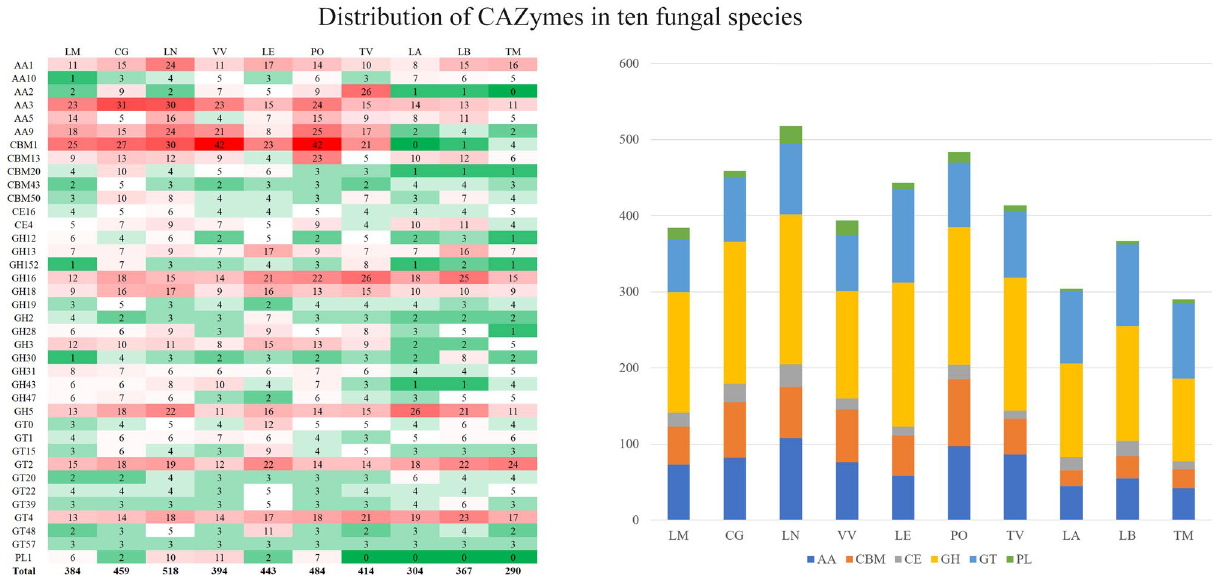
Figure 3. Statistics of CAZymes. ( a ) Heatmap showing the number of paralogs of CAZyme genes per species for families with an average of three or more paralogs among species. Warm colors represent higher numbers. Totals in the final row refer to the total numbers of genes per species. ( b ) Statistics for all CAZymes genes among the ten filamentous fungal species. The horizontal axis represents the species name and the vertical axis represents the number of CAZymes